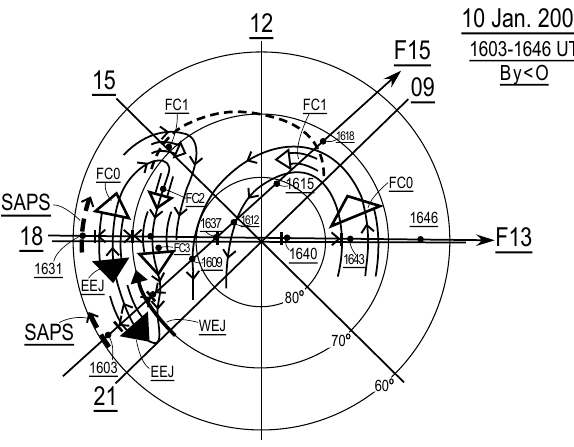
Fig. 2. Observation geometry placed in the context of global plasma convection as derived from DMSP F13 and F15